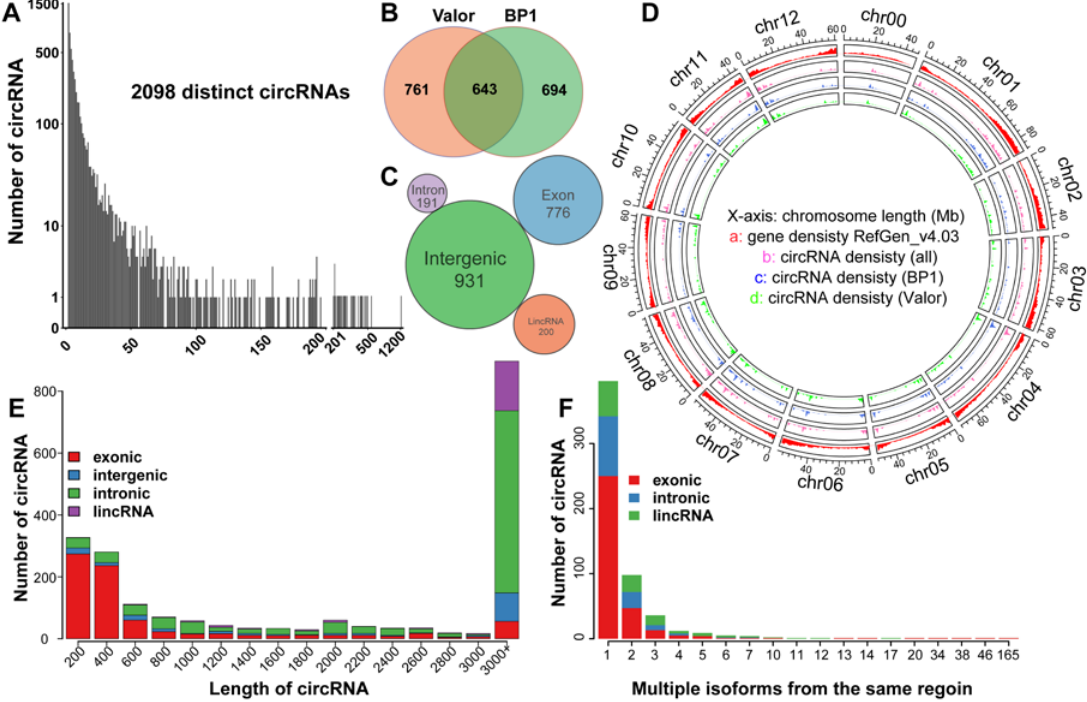
Figure 1. Characterization of potato circular RNAs (circRNAs). ( A ) Number of circRNAs and their supporting backsplicing reads. ( B ) Distribution of circRNAs in both cultivars. ( C ) CircRNAs genomic origin. ( D ) Distribution of circRNAs in each chromosome. ( E ) Distribution of circRNAs in different length ranges (e.g., 200 represents 0–200). ( F ) Summary of alternative circularization events.